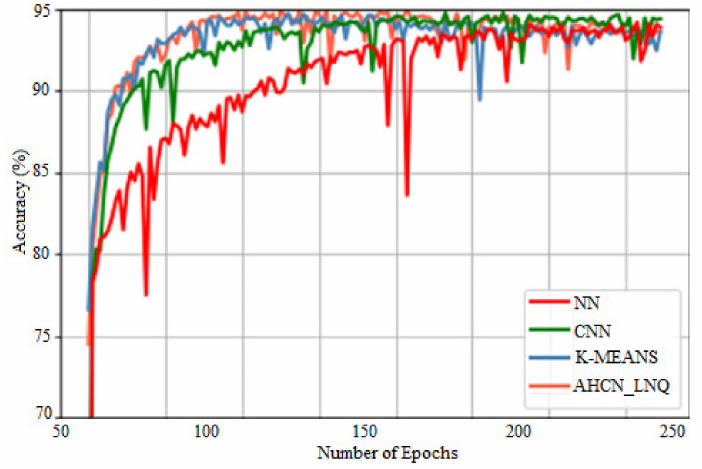
Figure 5. Comparison of accuracy.